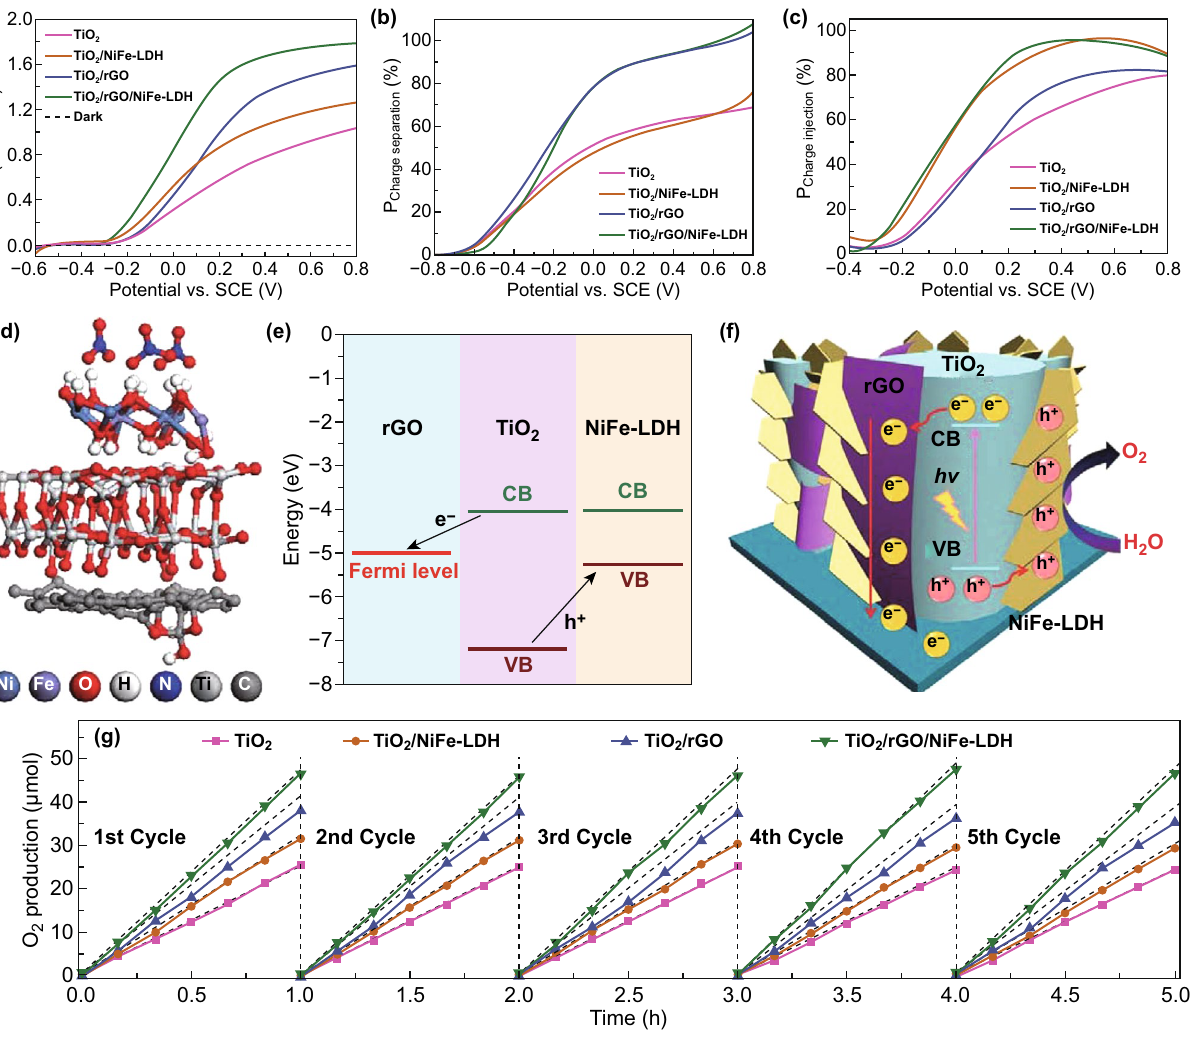
Fig. 9 a Current–potential curves, b charge separation, and c injection efficiencies vs. potential of TiO 2 , TiO 2 /NiFe-LDH, TiO 2 /rGO, TiO 2 /rGO/ NiFe-LDH photoanodes, d optimized geometries of TiO 2 /RGO/NiFe-LDH, e band alignments of TiO 2 , RGO, and NiFe-LDH, f scheme of water oxidation process in hybridized TiO 2 /rGO/NiFe-LDH photoanode, g actual O 2 evolution of TiO 2 , TiO 2 /NiFe-LDH, TiO 2 /rGO, TiO 2 /rGO/NiFe- LDH (the dot lines denote the theoretical O 2 generation estimated from the measured photocurrent with Faradaic efficiency of 100%). Repro- duced with permission from Ref. [156]. Copyright 2016 Royal Society of